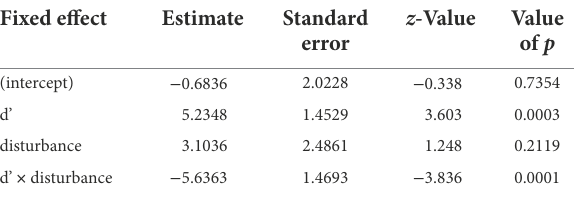
TABLE 2 Relationship between seed:ovule ratio, specialization (d’) and